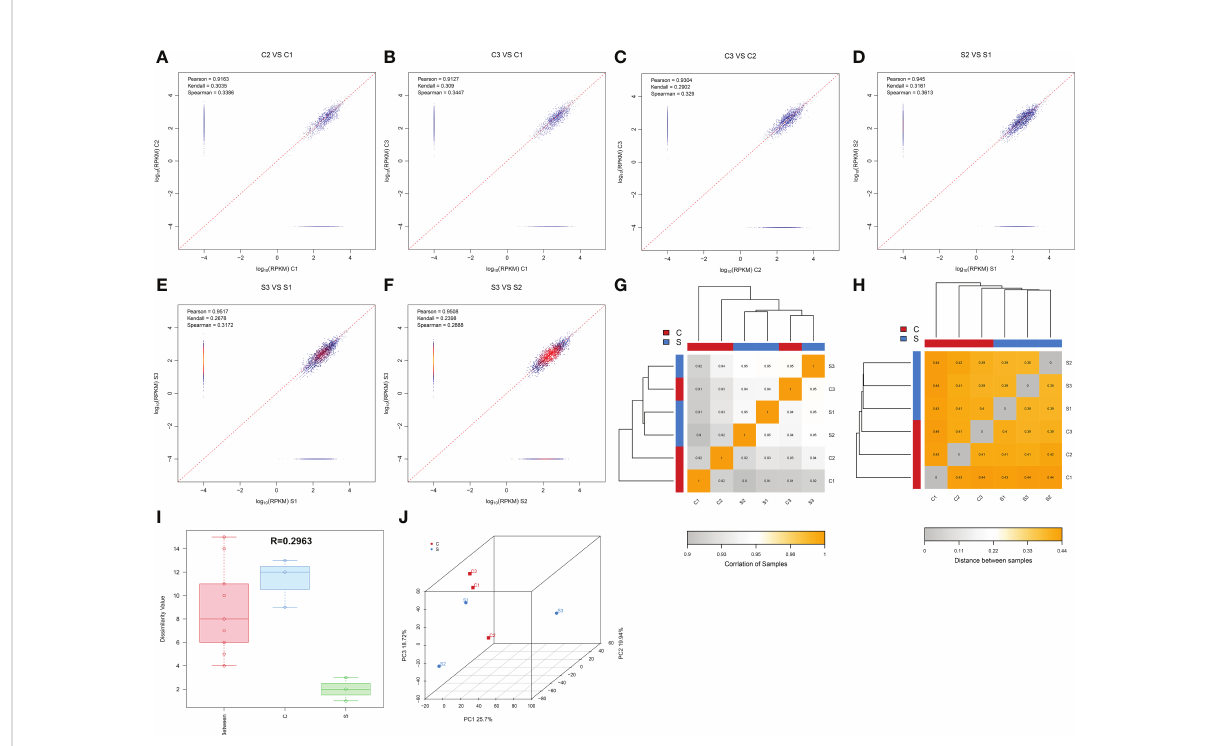
FIGURE 1 Determining the reasonable for the samples selection. (A – F) Duplicate correlation check scatter plot. The horizontal and vertical coordinates are the log 10 (RPKM) values for the two samples, respectively. Three correlation indices are calculated in the fi gure: pearson, kendall, and spearman. The more similar the samples are, the closer the similarity index is to 1, and most of the points will be concentrated near the diagonal. (G) Inter-sample correlation analysis Heatmap. The color block represents the correlation index value. The grayer the color, the lower the correlation index among samples. The yellower the color, the higher the correlation index. (H) Heatmap of distance between samples. The color block represents the distance value. The grayer the color, the closer the distance between samples and the higher the similarity. The yellower the color, the farther the distance is. (I) : Anosim between-group similarity analysis boxplot. The boxes on the left refer to the between-group differences, and the middle and right boxes represent the within-group differences of the normal and SCI groups, respectively. The R value ranges from -1 to +1, with an R value closer to 1 indicating greater between-group differences than within-group differences. (J) Principal component analysis diagram, the horizontal and vertical coordinates re fl ect the relative distance between samples. Red points indicate control group, whereas green points indicate SCI